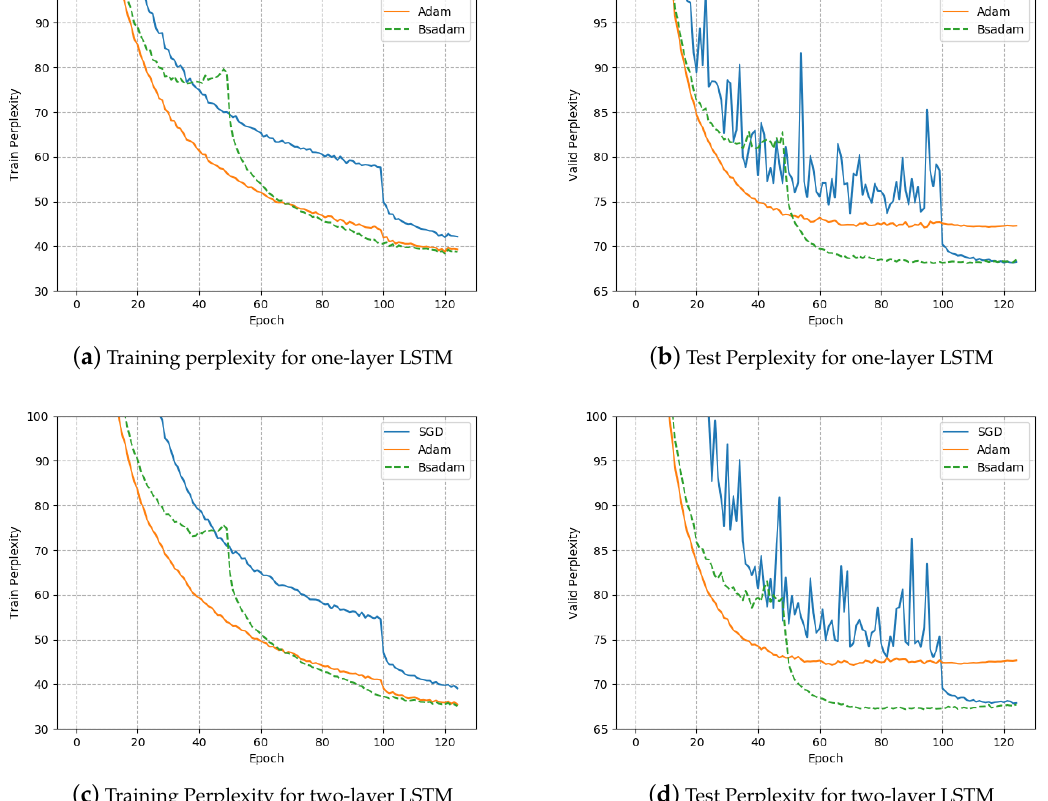
Figure 6. Training and valid perplexity for long short-term memory (LSTM) with different layers on Penn